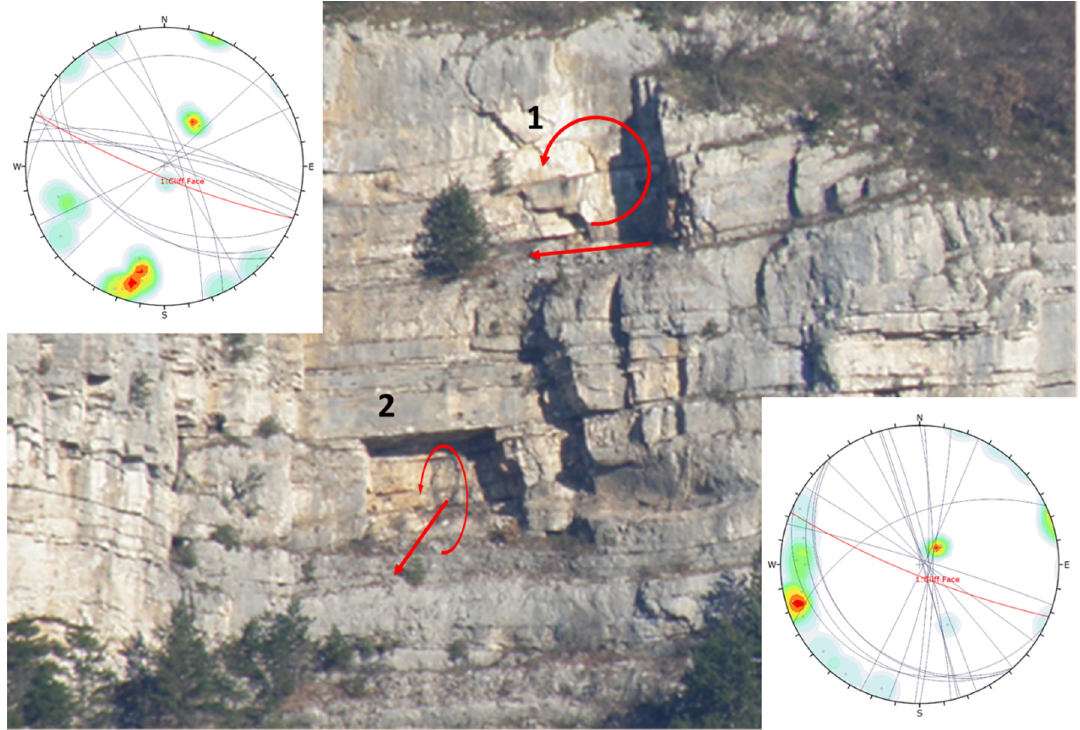
Figure 12. A view of the central part of the Raspadalica Cliff (Zone 3) with two signs of previous rockfall instability (1, 2). Stereographic presentations of discontinuities are present in the figure (1 left up, 2 right down) and appropriate kinematic analysis do not indicate planar or toppling instabilities.